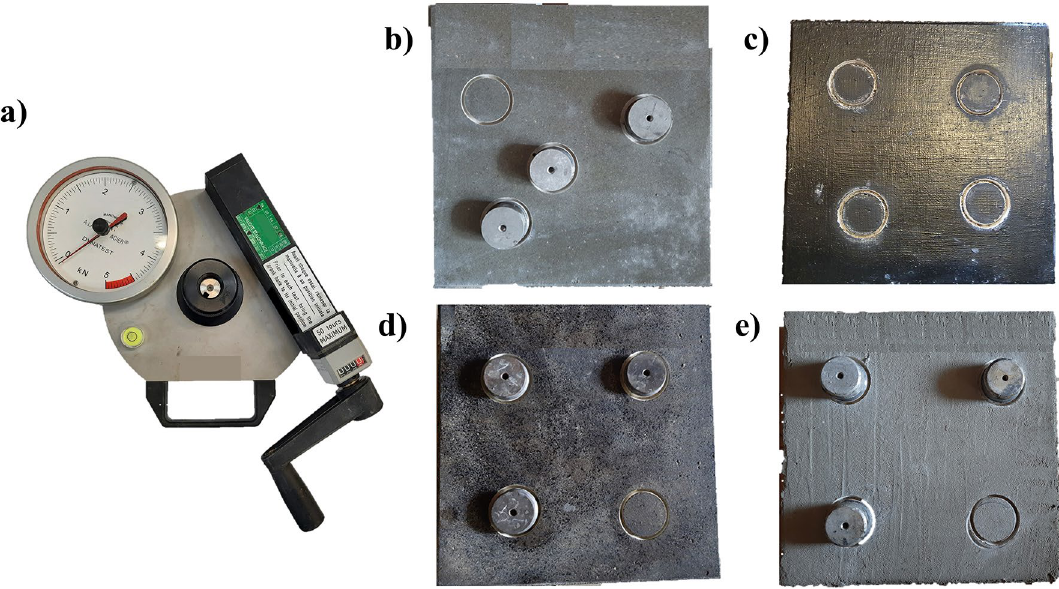
Figure 4. ( a ) Equipment used. Concrete slabs preparation for pull-off adhesion test: ( b ) EP ( c ) BW ( d ) BR ( e )